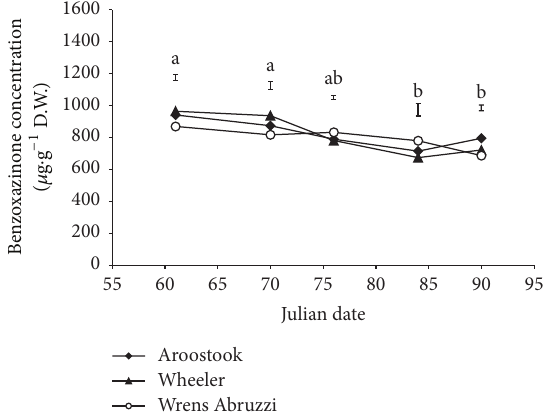
Figure6:Variationoftotalbenzoxazinonecontent(sumofDIBOA- glucoside, DIBOA, and BOA) in shoot tissue of three rye cultivars between dates 61 and 90 (Julian dates) of the second year of exper- iments. Values associated with the same letter are not significantly different according to the Tukey-Kramer method ( 𝑝 < 0.05 ). Vertical bars represent standard errors at each sampling